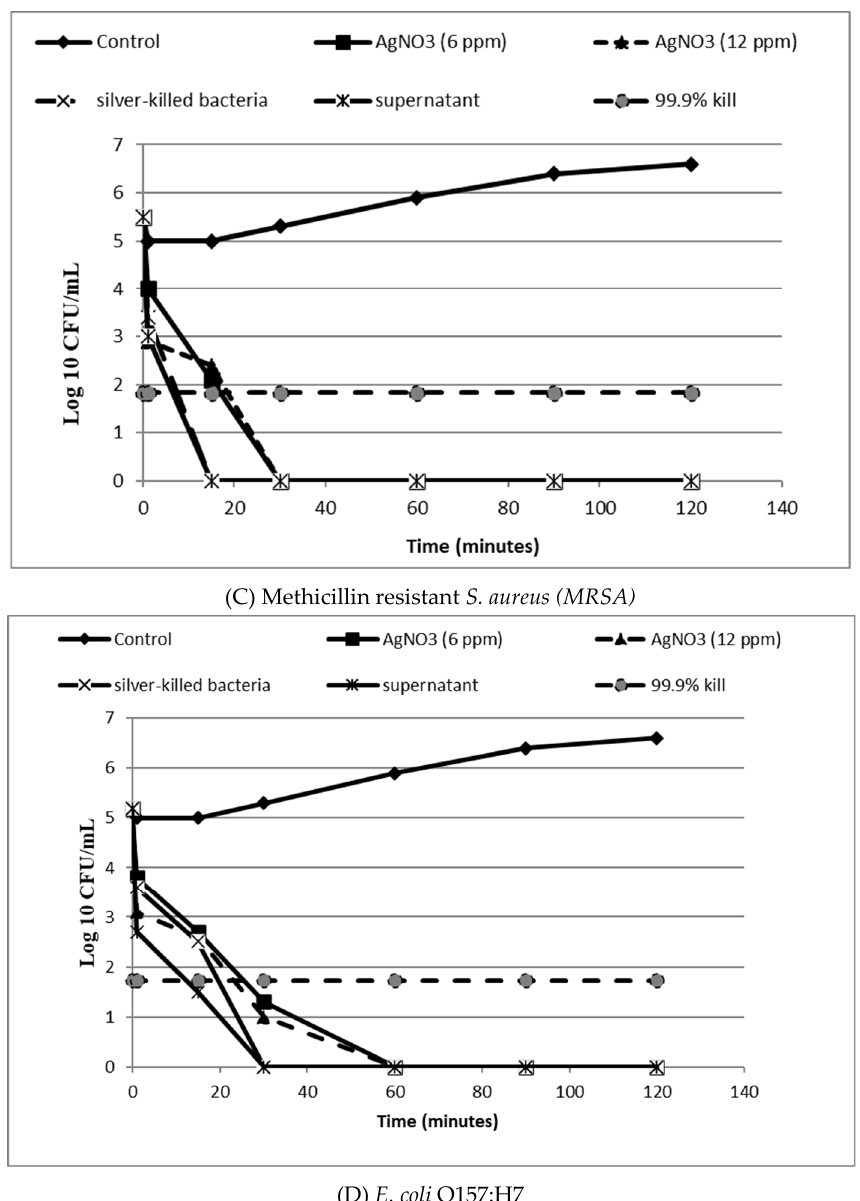
Figure 6. Time-kill curves of silver treated bacteria (killed bacteria suspension and supernatant), silver nitrate solutions at 6 and 12 ppm against E. coli O104:H4 ( A ) Ps. aeruginosa ( B ) MRSA ( C ) E. coli O157:H7 ( D ) in comparison to control (untreated).